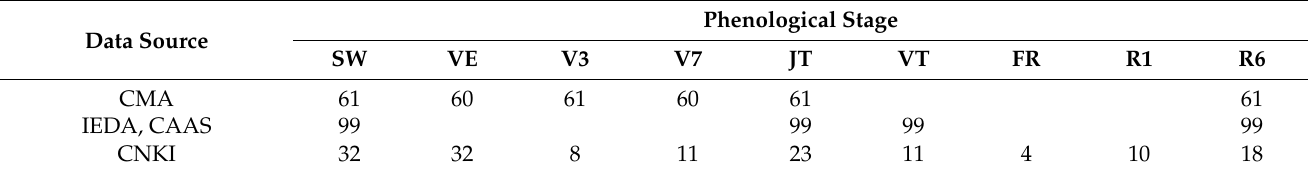
Table 1. Details of the nine phenological stages recorded in the three base data sets used in this study (see text for details of sources). Numbers refer to the number of records per phenological stage. The location of records is shown in Figure 1. See text for explanation of each phenological stage.